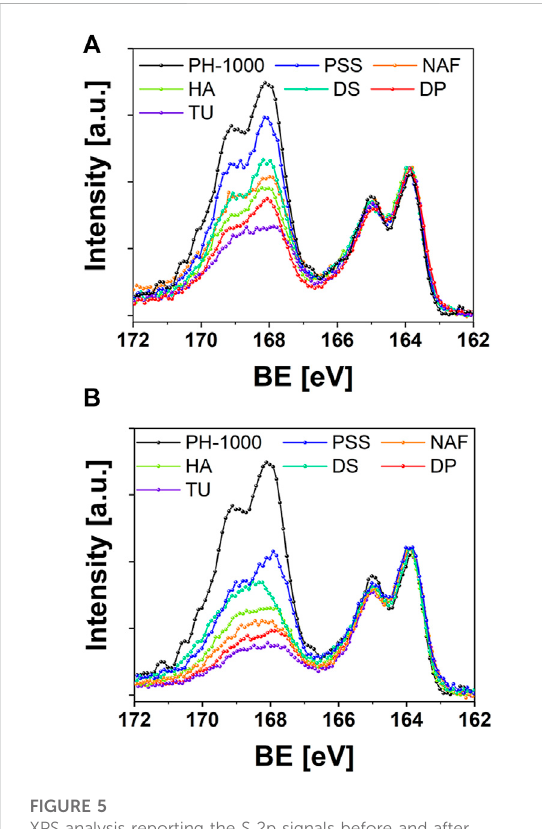
FIGURE 5 XPS analysis reporting the S 2p signals before and after electrodeposition of PEDOT/X at (A) Q dep = 25 mC cm − 2 and (B) Q dep = 100 mC cm − 2 .